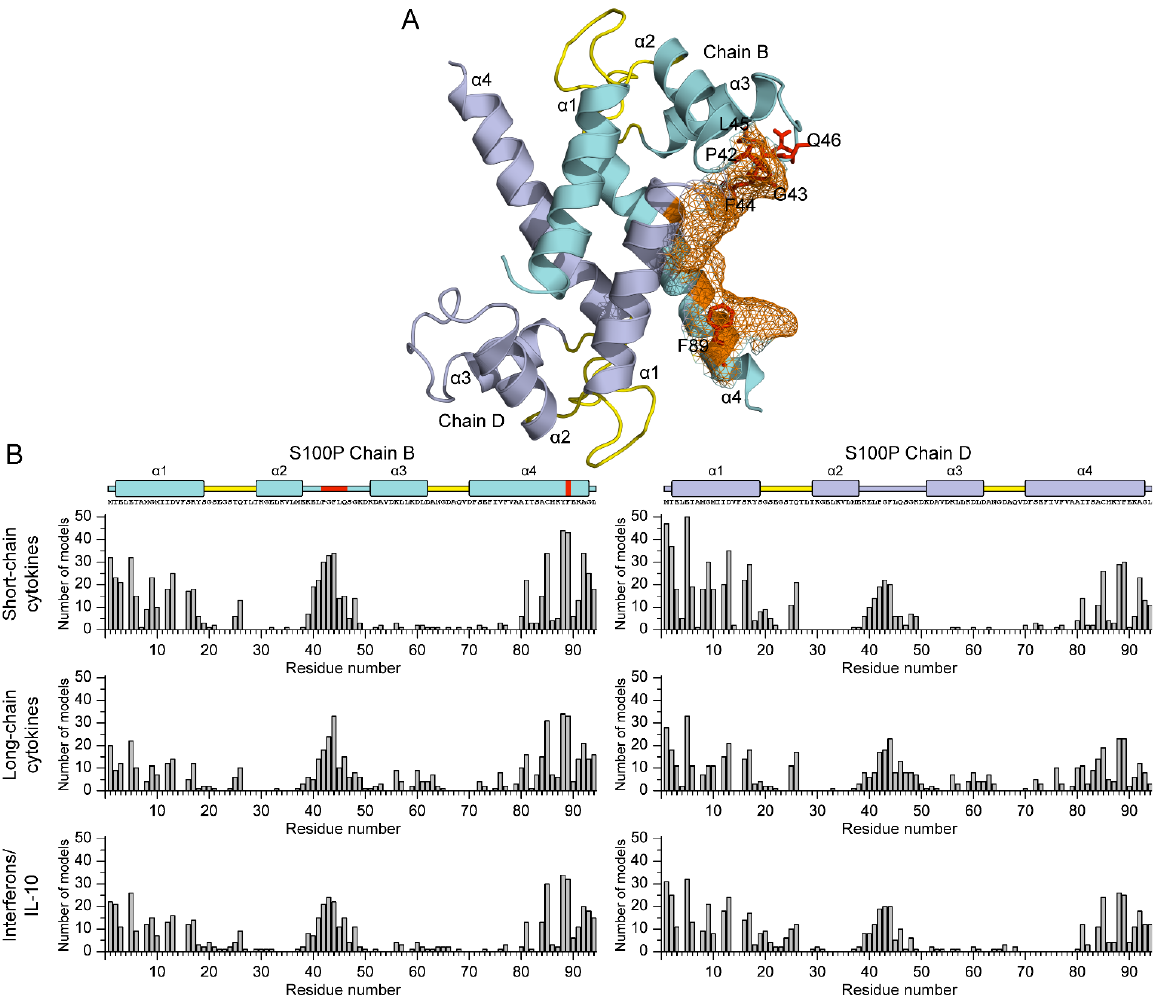
Figure 5. (A) Tertiary structure of Ca 2+ -loaded S100P dimer (PDB entry 2MJW): chains B and D are highlighted in cyan and gray, respectively; the α -helices are labelled as α 1- α 4; the Ca 2+ -binding loops are yellow-colored. The residues predicted to constitute the cytokine-binding site are shown as orange mesh surface: residues P42, G43, F44, C85, Y88, and F89 (chain B), and residues M1 and E5 (chain D). The residues P42, G43, F44, L45, Q46, and F89 (see Table 4) of chain B are depicted as red balls and sticks. (B) Distributions of the predicted contact residues of Ca 2+ -loaded S100P dimer over its amino acid sequence within models of S100P complexes with representatives of specific families of four-helical cytokines (see Table S4). Ten docking models were taken into account for each S100P–cytokine pair. The boundaries of secondary structure elements of S100P were taken from PDB entry 2MJW; the residues P42, G43, F44, L45, Q46, and F89 (see Table 4) of chain B are indicated in